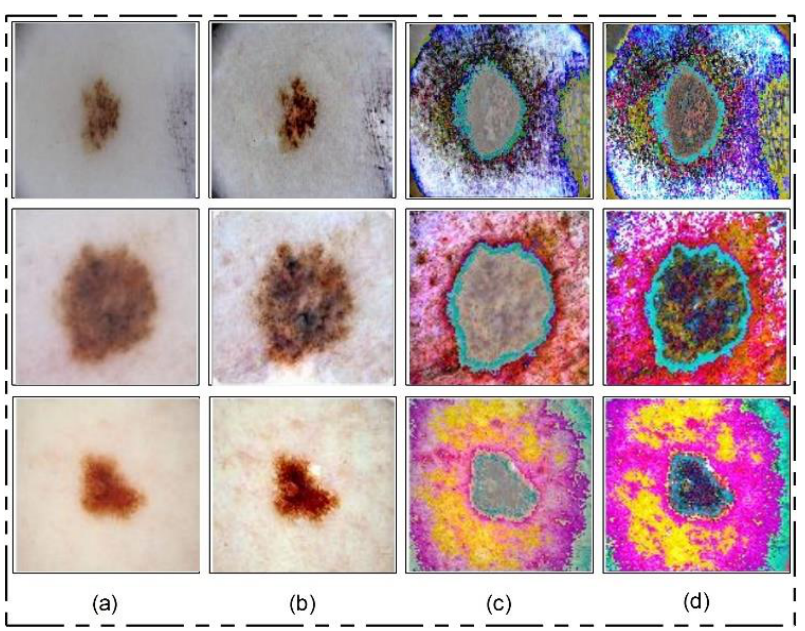
Figure 6. Lesion contrast stretching results. ( a ) Original Image; ( b ) fused image; ( c ) output of first fitness function; ( d ) output of second fitness function.